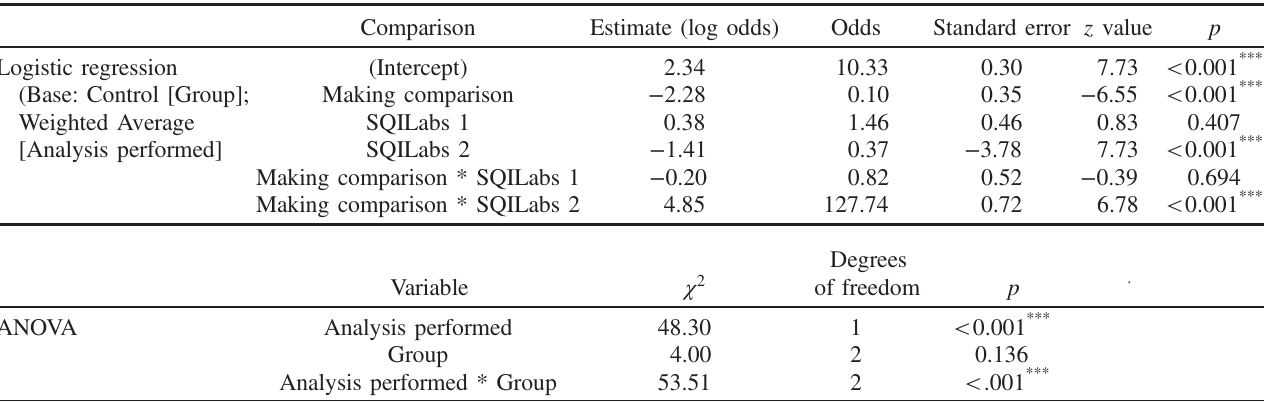
TABLE III. Logistic regression table for students ’ analysis tool use. Base comparison is the control group (for year) and calculating a weighted average (for analysis performed). . p < 0 . 1 , * p < 0 . 05 , ** p < 0 . 01 , *** p < 0 . 001 .